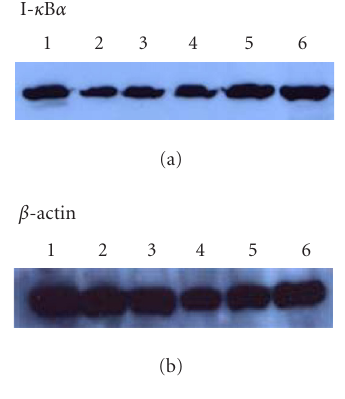
Figure 6. Western blotting showed levels of I κ B α in colon tis- sue of rats. Lanes 1–6: normal, model, melatonin (2.5, 5.0, 10.0 mg.kg − 1 ),